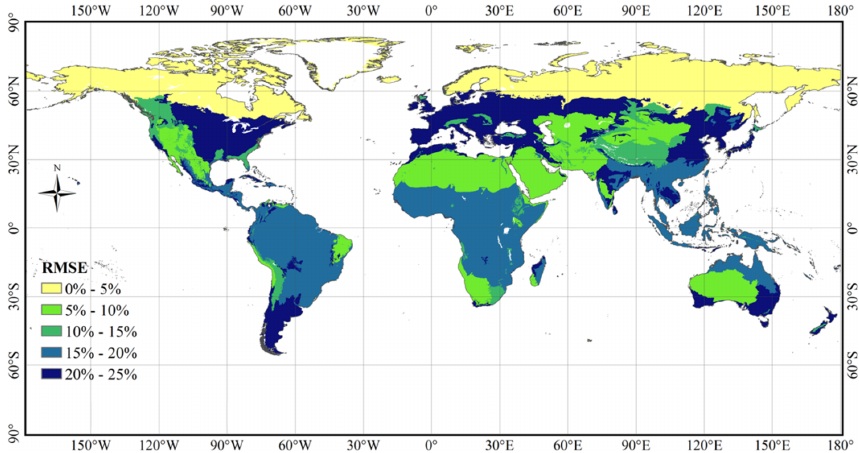
Figure 13. Random-forest-based suitability evaluation performance in different WWF biome